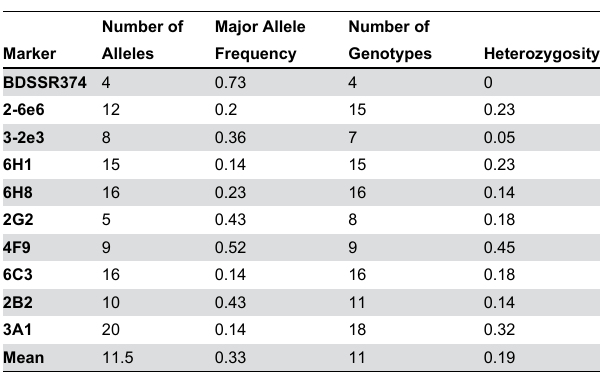
Table 2. SSR Marker summary.